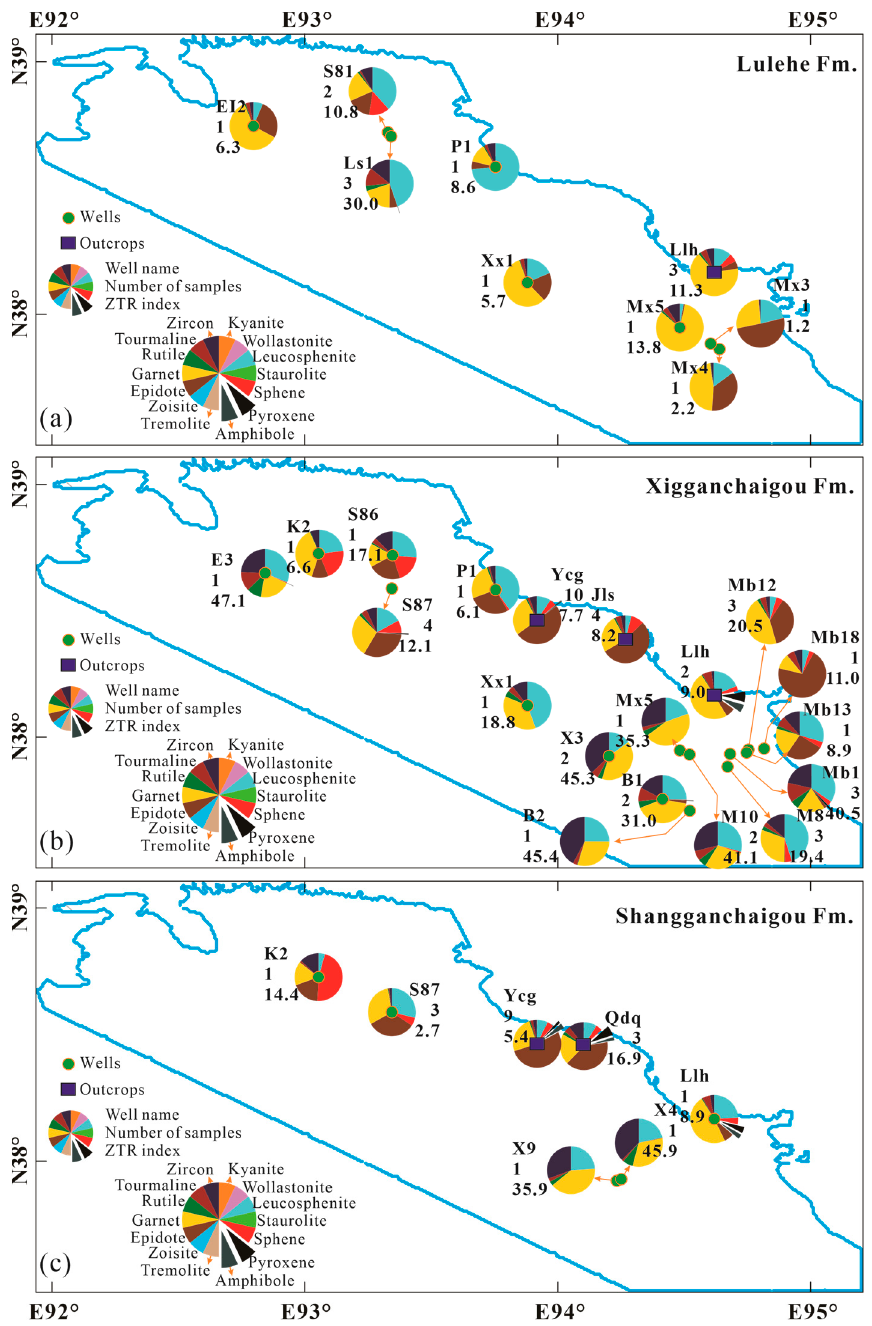
Figure 4. The characteristics of the heavy mineral assemblages of the Paleogene strata. ( a ) Lulehe Fm. ( b ) Xigganchaigou Fm. ( c ) Shangganchaigou Fm.